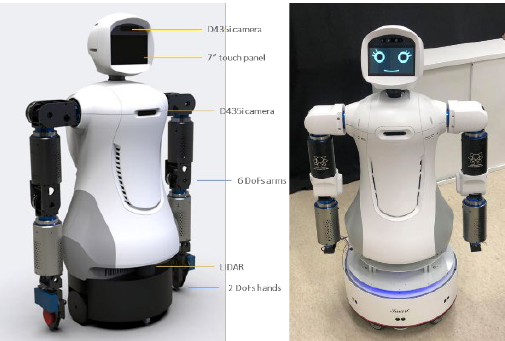
Figure 12. The mobile robot Mobi.